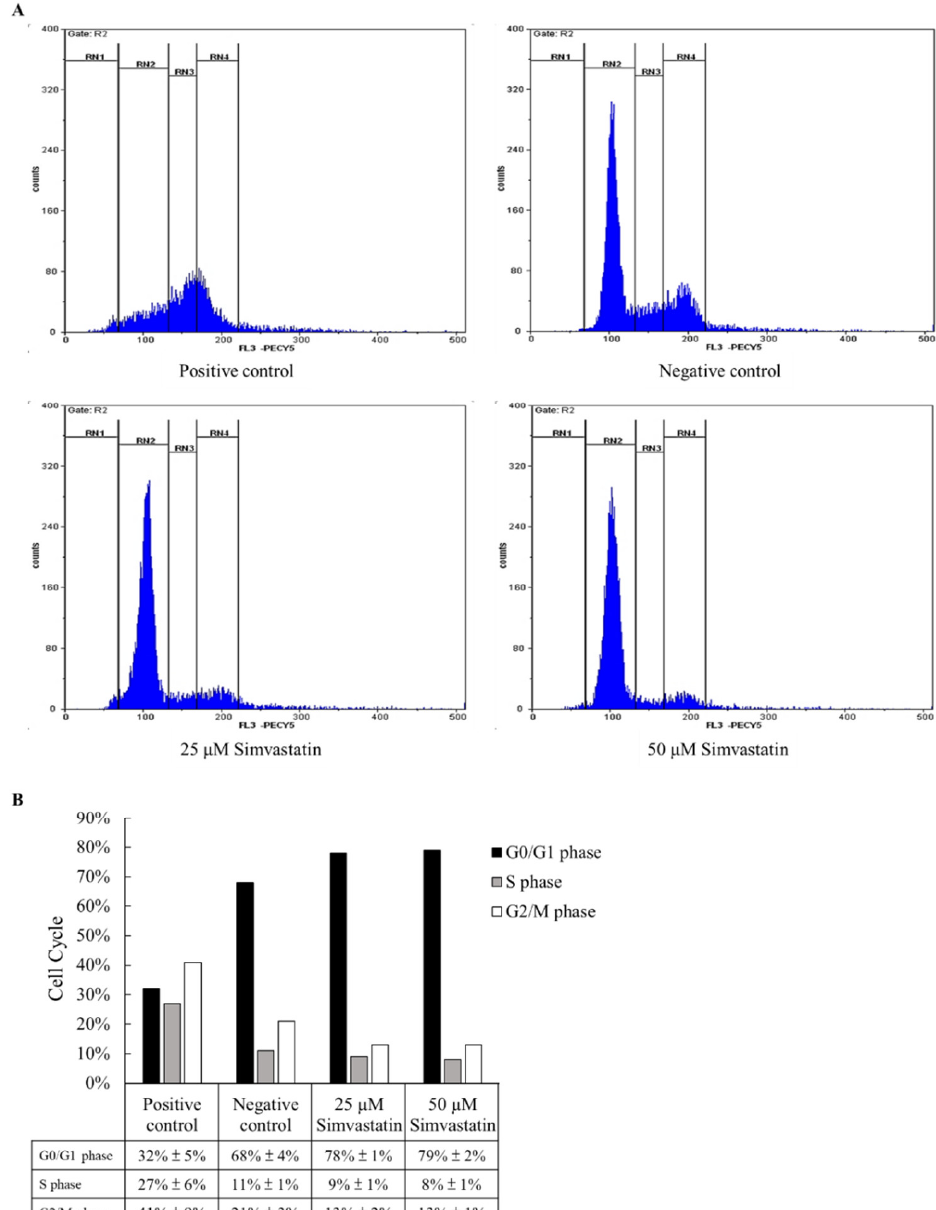
Figure 2. The cell cycle analysis by flow cytometry indicated the effects of different simvastatin concentration treatments. ( A ) Cells were treated with different concentration of simvastatin and cell cycle changes were observed using flow cytometry. ( B ) Statistical results of each phase in cell cycle. The 50 μM simvastatin treatments revealed more G0/G1 phase arrest in MIA PaCa-2 cells. ( n = 6) .